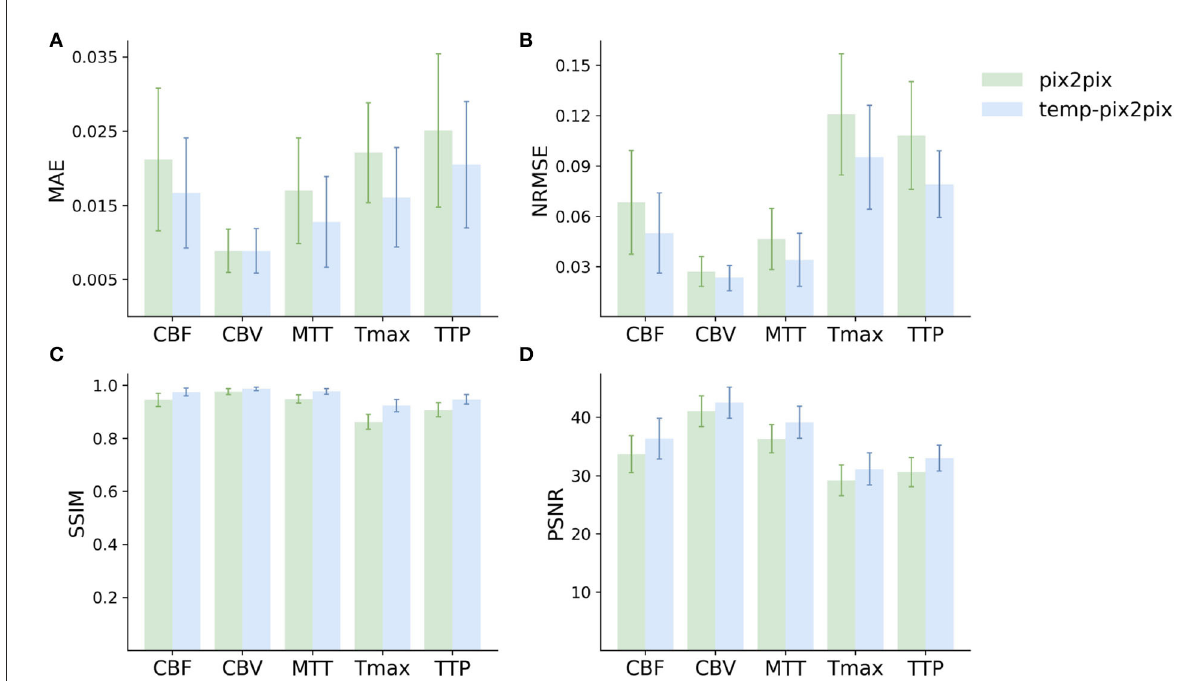
FIGURE5 Mean performance metrics for evaluating the similarity between the ground truth and the synthesized parameter maps generated by the pix2pix GAN (green) and the temp-pxi2pix GAN (blue) on the acute stroke dataset. (A, B) Show the mean absolute error (MAE) and normalized mean root squared error (NRMSE), respectively (the lower, the better). (C, D) Show the structural similarity index measure (SSIM) and the peak-signal-to-noise-ratio (PSNR) (the higher, the better). For all parameter maps, the temp-pix2pix architecture shows a better or comparable performance compared with the pix2pix GAN. For the time-dependent parameter maps such as Tmax and TTP, the difference between the pix2pix and temp-pix2pix GAN performance is larger than the other three maps. The error bar represents the standard